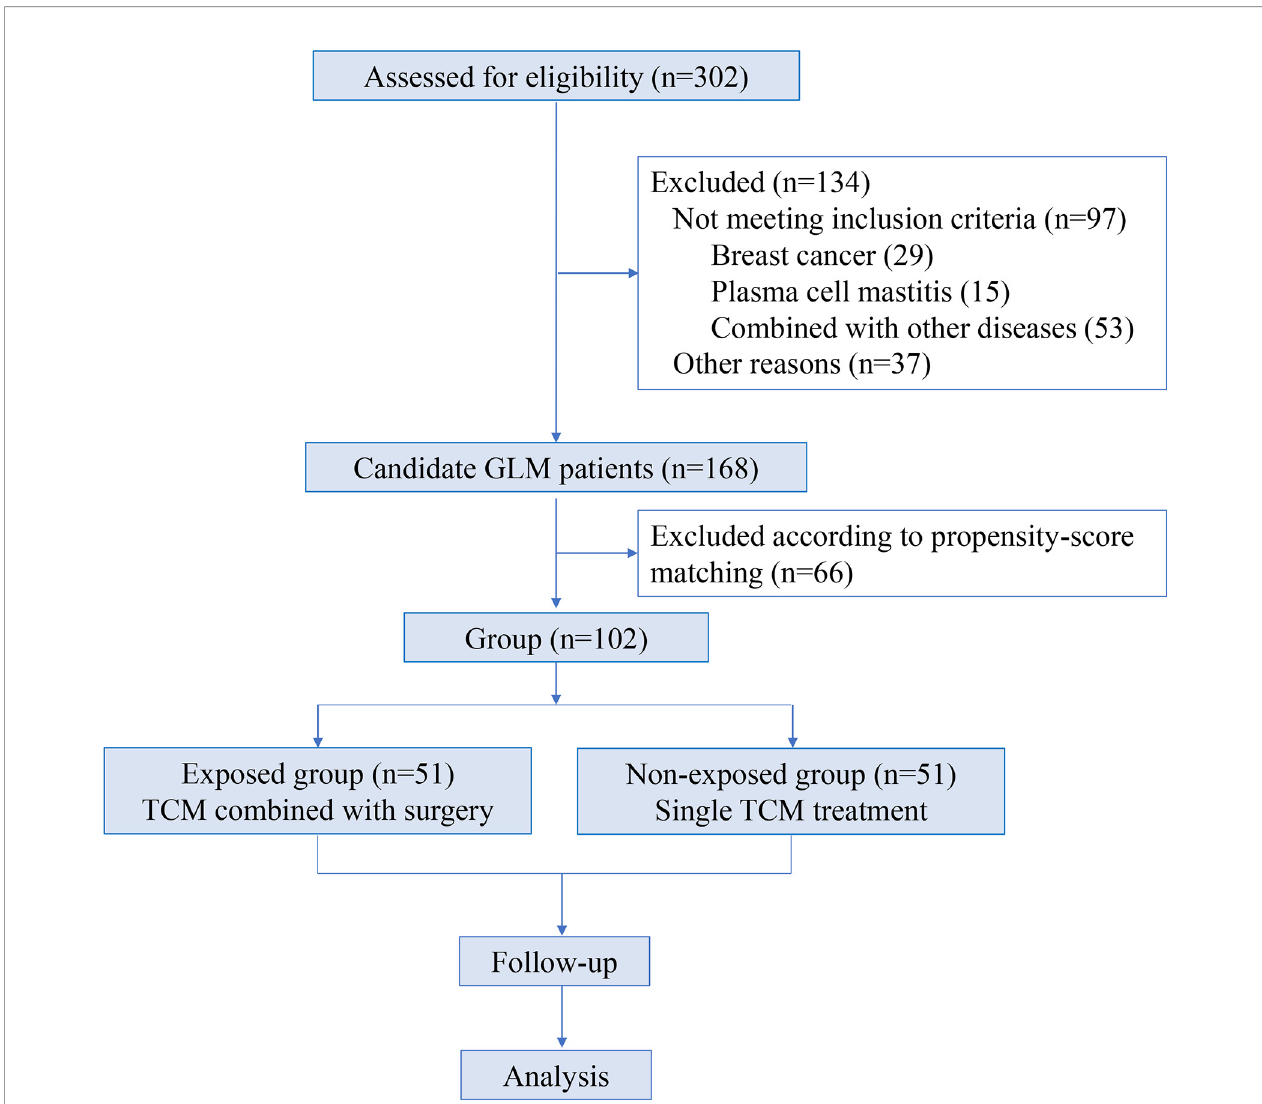
FIGURE 1 | Flow diagram of the